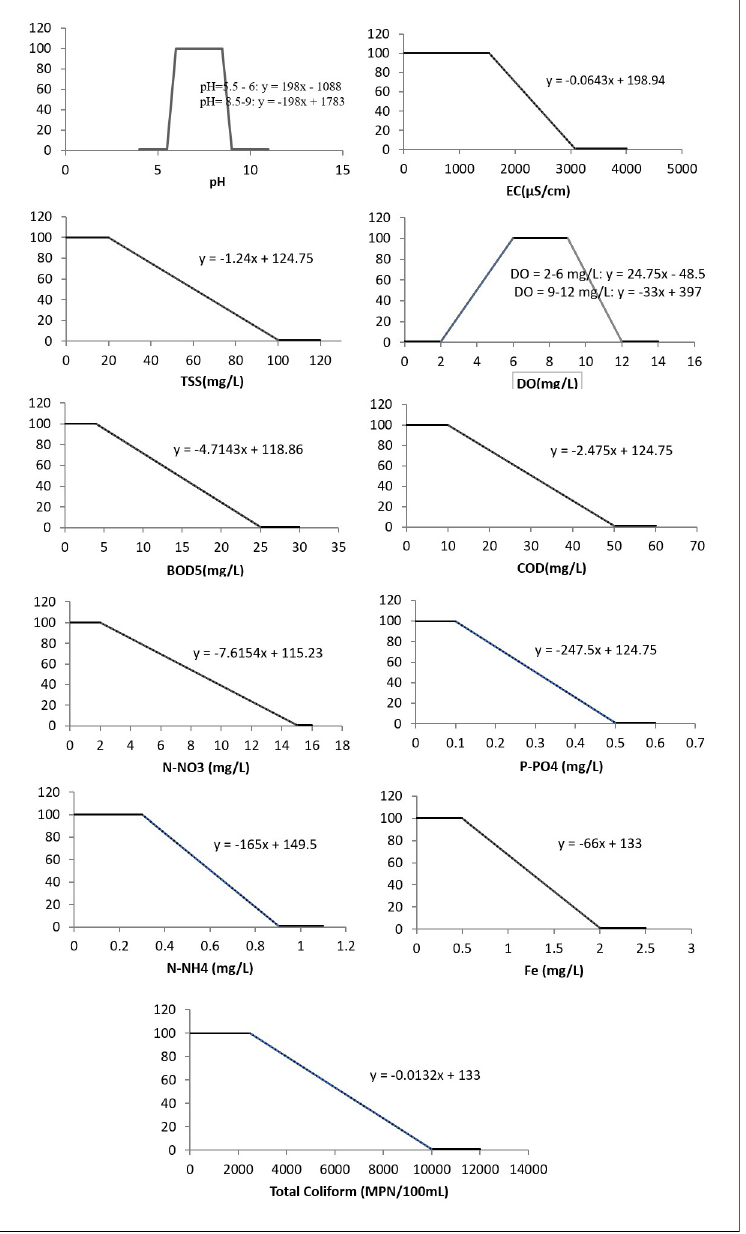
Fig 3. The linear curve and equation(s) for each parameter to transform the concentration x (in the abscissa) into the grade y (or sub-index q) in the ordinate.